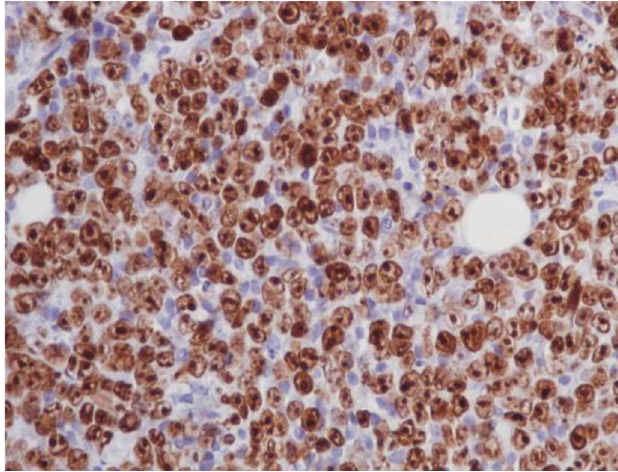
Fig. 4. The Ki-67 cell proliferation index was approximately 95% (X